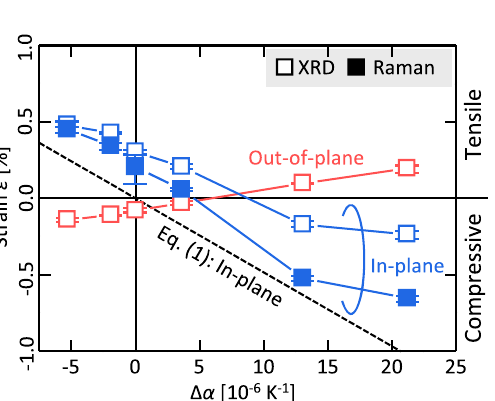
Figure 2. XRD analysis of the Ge layers on various substrates. ( a ) Out-of-plane θ –2 θ XRD patterns; data for the bulk Ge (111) wafer are shown for comparison. The inset shows a magnified view focused on the Ge 111 peaks. ( b ) In-plane φ –2 θ χ XRD patterns. ( c ) Ge 111 peak position (2 θ and 2 θ χ ) as a function of Δ α ; the value for the bulk Ge (111) wafer is shown by the dotted line. The error bars indicate the variability in the XRD measurements at four locations for each 1-cm square sample.